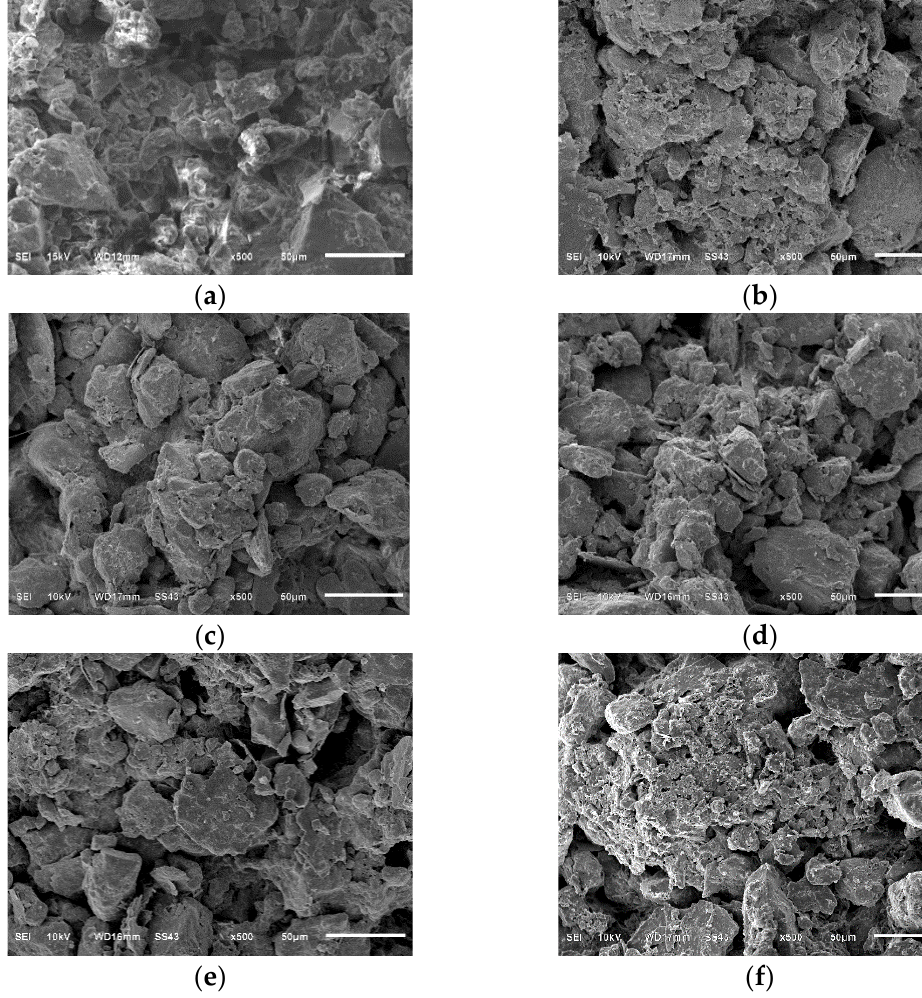
Figure 7. SEM images of undisturbed loess at different freeze–thaw cycles (500 times). ( a ) The number of freeze–thaw cycles is 0. ( b ) The number of freeze–thaw cycles is 2. ( c ) The number of freeze–thaw cycles is 6. ( d ) The number of freeze–thaw cycles is 10. ( e ) The number of freeze–thaw cycles is 15. ( f ) The number of freeze–thaw cycles is 20.